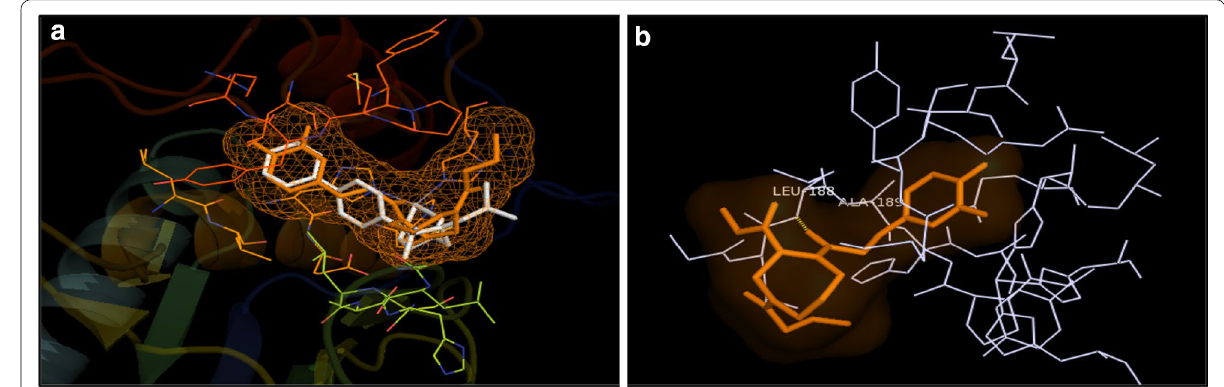
Fig. 11 a Overlay of the docked pose of compound 16 (orange) with that of PDB Ligand 4H3X (white); b docked pose: H-bond interaction of compound 16 in the binding site of MMP-9